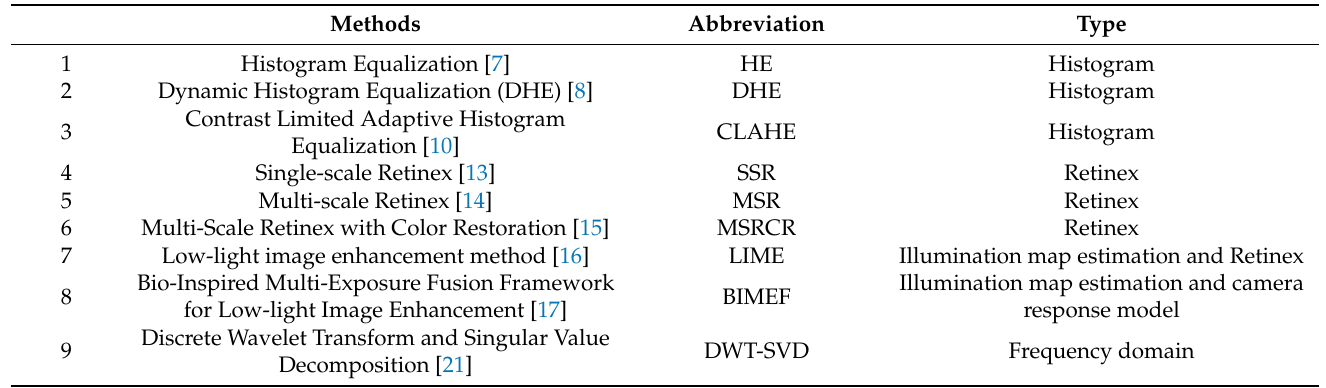
Table 1. Methods for comparison experiments.